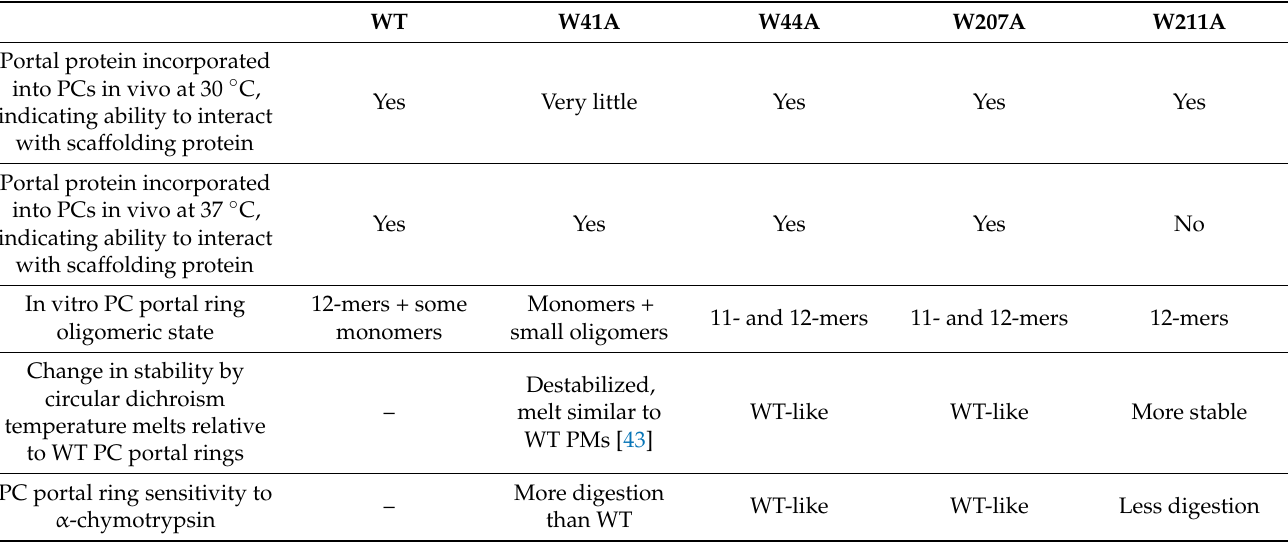
Table 4. Summary of results of the lethal W → A portal protein substitutions.